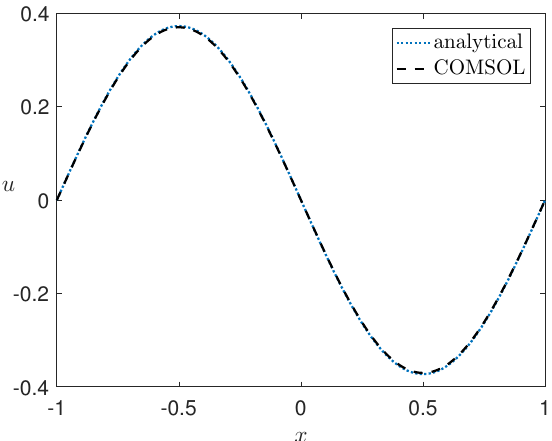
Figure 3. Comparison of the analytical solution with the solution computed by COMSOL Multiphysics with 66,142 elements for T = 0.1, y = −